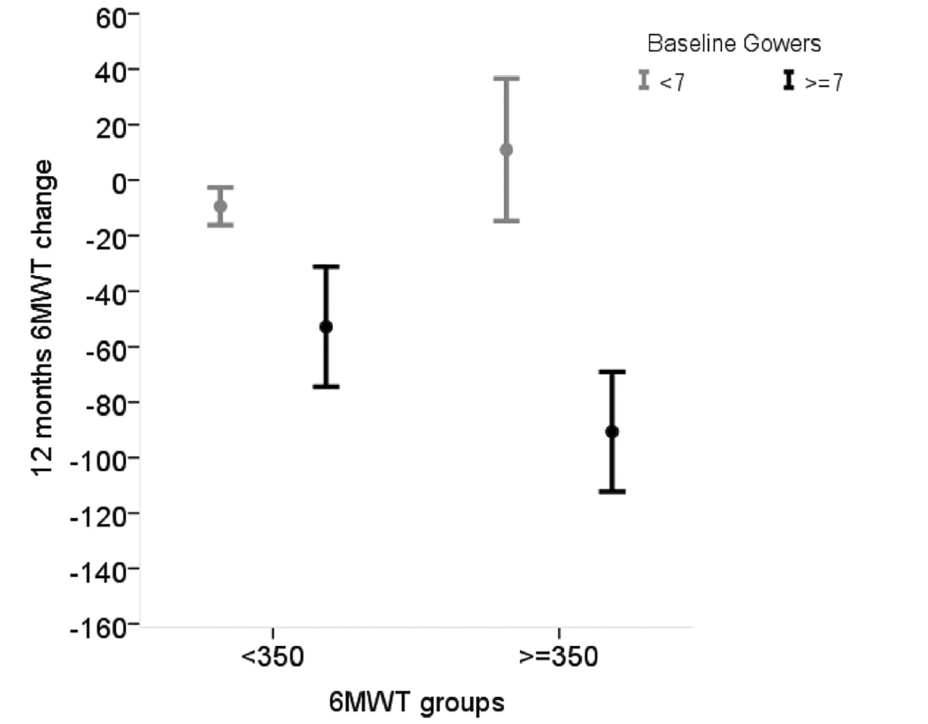
Fig 5. Average 6MWT change over 12 months according to baseline values of 6MWD ( < 350 vs > = 350) in those with baseline TRF < 7 sec and in those with baseline TRF > = 7sec. There is no 6MWD by TRF interaction, indicating that that the baseline value of 6MWD has the same impact on the 6MWD change according to different baseline TRF